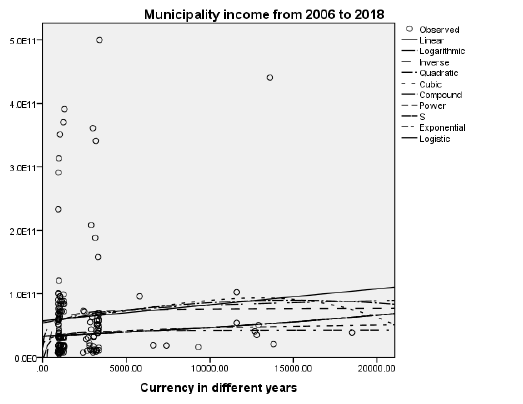
Figure 7: Models or Equations Fitting